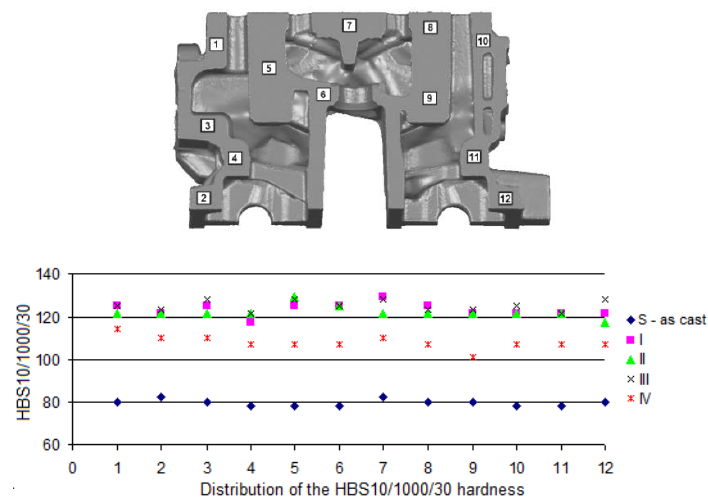
Figure 9. Areas of hardness measurement on the casting of the cylinder head—cross-section no. 2.